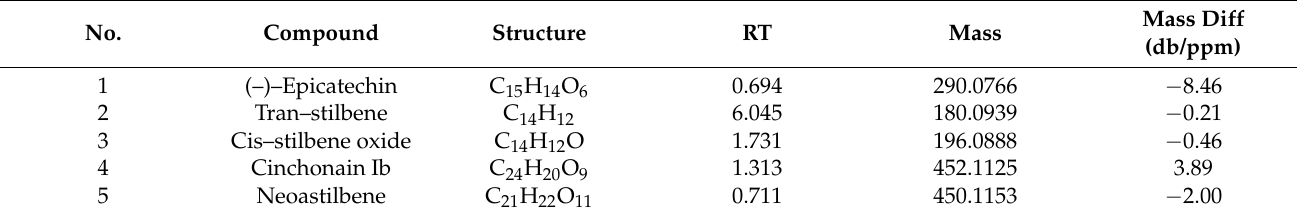
Table 3. Compounds in the library according to